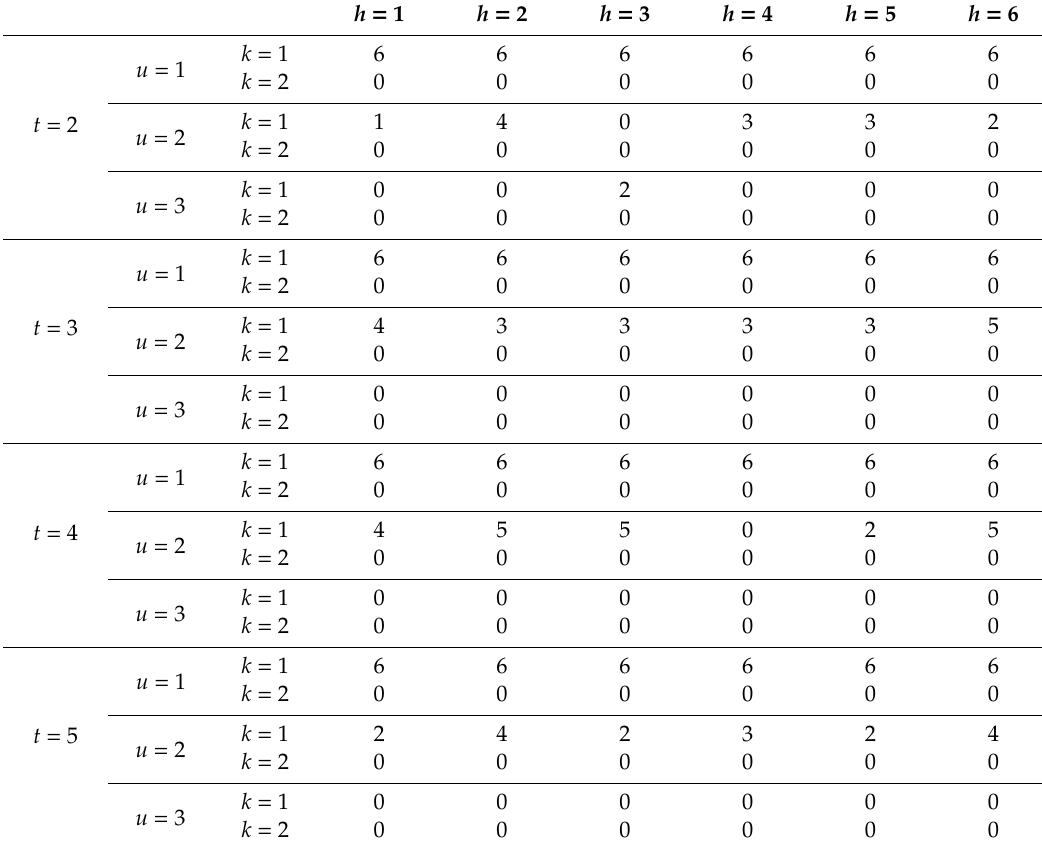
Table A4. Required number of each vehicle between distributor “ d = 2” and hospitals in period t = 2–5.